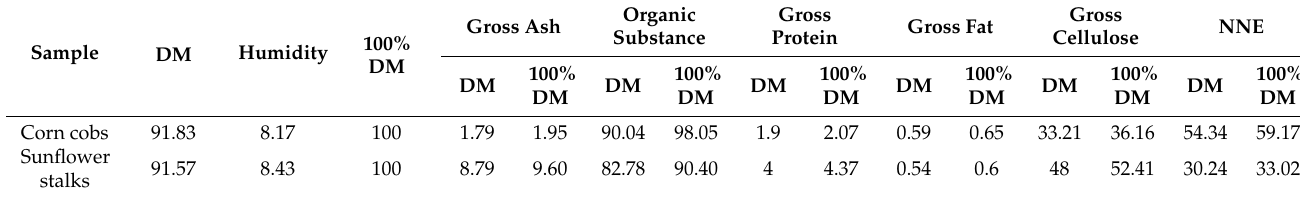
Table 1. Organic chemical composition of corn cobs and sunflower